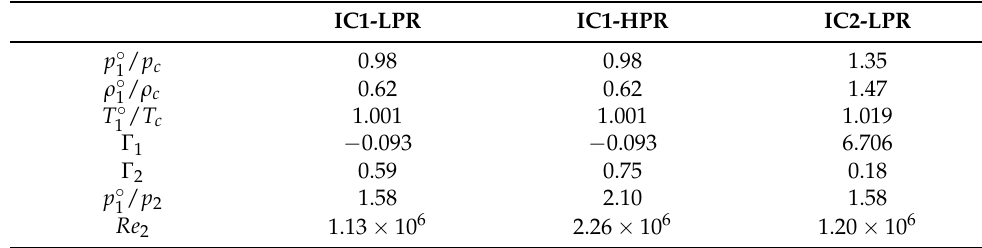
Table 1. Thermodynamic conditions for dense gas simulations. p ◦ , ρ ◦ , and T ◦ are the total pressure, density, and temperature, respectively, p c , ρ c , and T c are the critical pressure, density, and temperature, Γ is the fundamental derivative of gas dynamics, and Re is the Reynolds number. The indices 1 and 2 denote the inlet and outlet conditions,